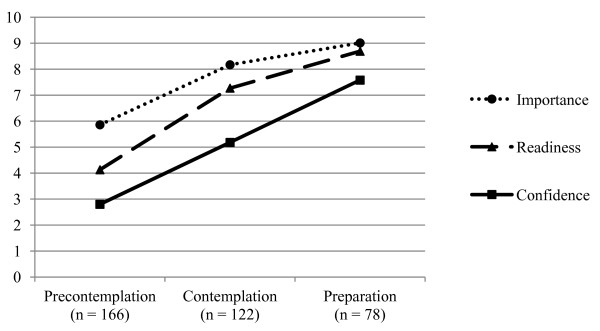
Stage of change and motivation rulers.